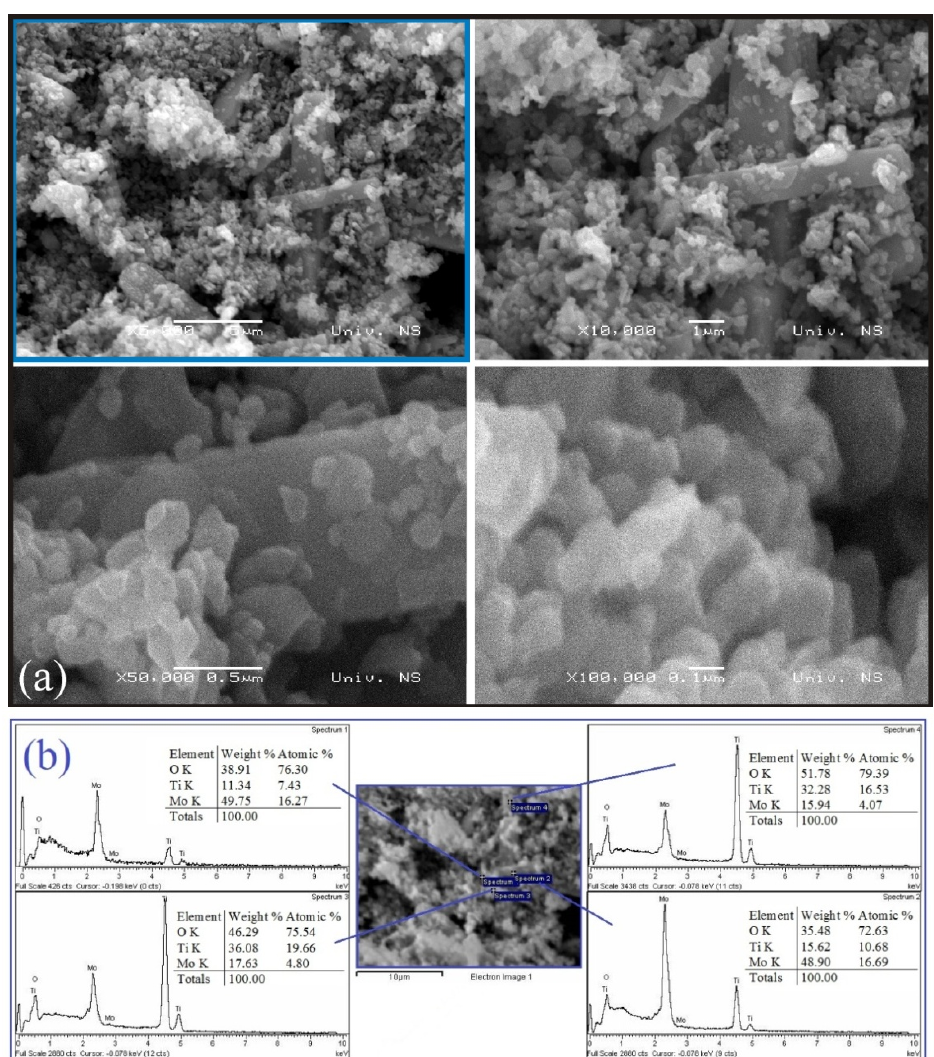
Figure 4. SEM images of TMO with higher magnifications (up to × 100,000) ( a , b ) energy-dispersive X-ray spectroscopy (EDS) spectra of four specific TMO surface areas chosen by SEM imagingat × 5000 magnification (upper left SEM image in ( a ), framed blue). The measured UV-Vis reflectance spectra are used for the optical bandgap energy ( E g ) estimation by plotting the ( F ( R ) · h ν ) 1/ n vs. photon energy (h ν ) (Figure 5), where F ( R ) is the Kubelka-Munk transformation of the measured reflectance R (%) defined as (1 − R ) 2 /2 R . The model for the indirect bandgap transition is used and a value of n = 2 in ( F ( R ) · h ν ) 1/ n vs. photon energy (h ν ) plot [30]. The estimated value of the optical bandgap energy of TMO (3.26 eV) was between the estimated optical energy band values of the starting anatase TiO 2 and MoO 3 (3.43 eV and 3.11 eV, respectively). The optical absorption threshold, calculated by λ = 1240/ E g , of around 380 nm, 360 nm, and 398 nm for TMO, TiO 2 , and MoO 3 , respectively, indicates the potential for the visible absorption of these individual semiconductors in photocatalysis.